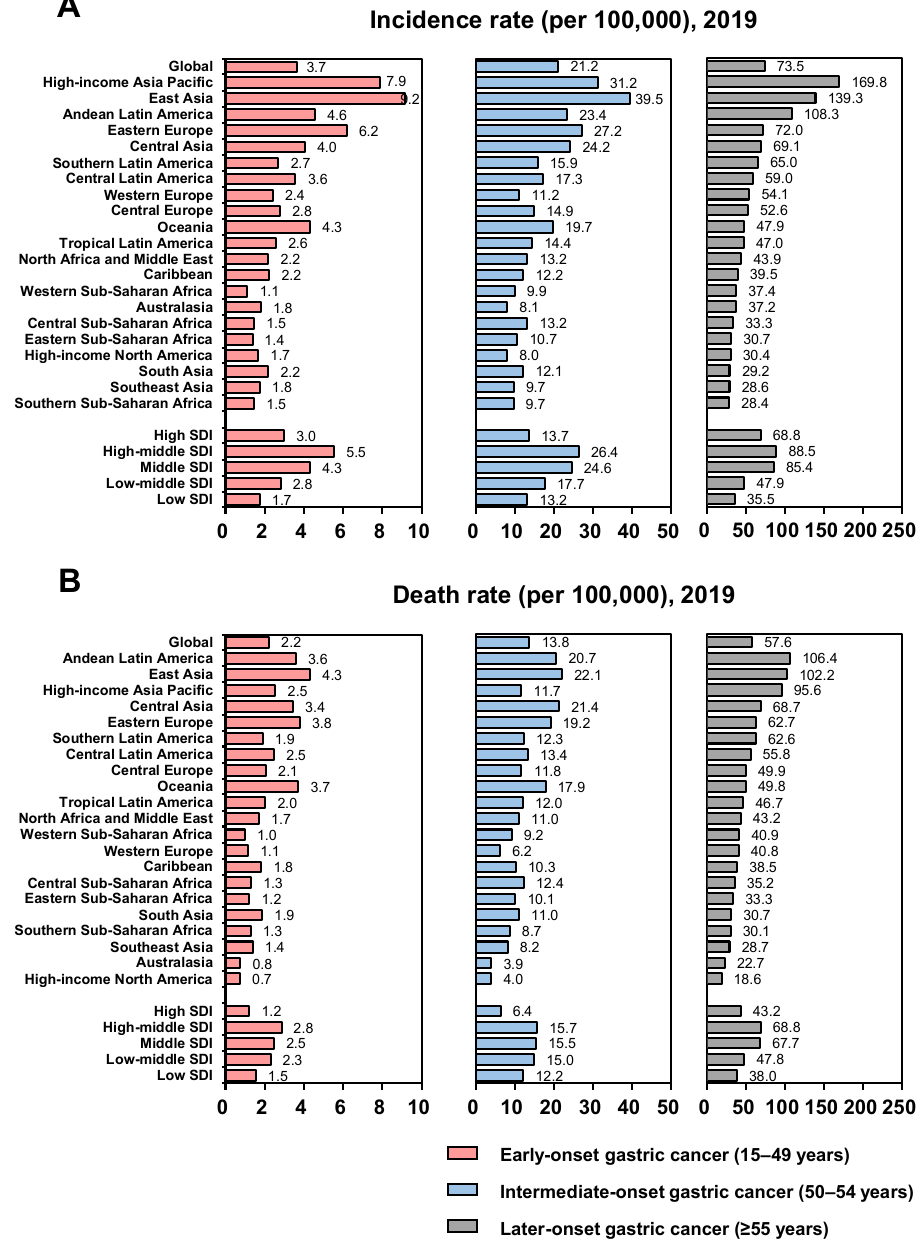
Figure 1. Incidence and death rates globally and by SDI and GBD regions in 2019. ( A ) Incidence rates globally and by SDI and GBD regions in 2019; ( B ) Death rates globally and by SDI and GBD regions in 2019. Table 1. Incidences and temporal trends in gastric cancers globally and by sex, and SDI and GBD regions, 1990–2019.